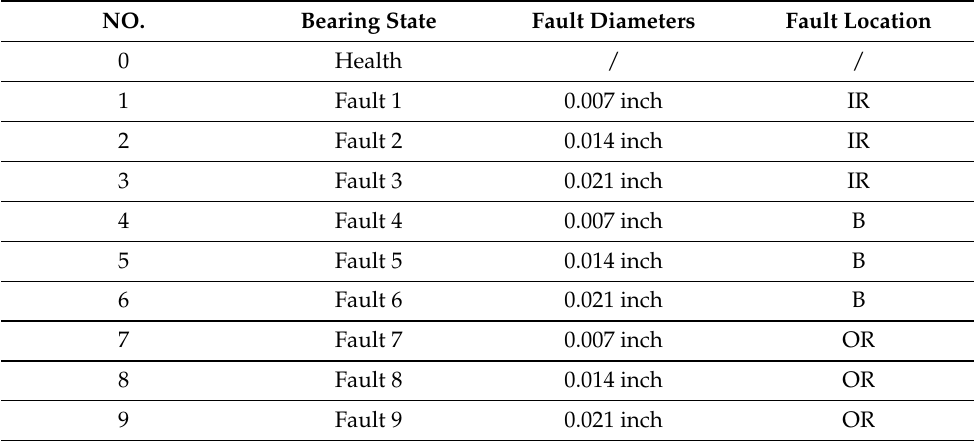
Table 5. Description of each type of fault in the CWRU